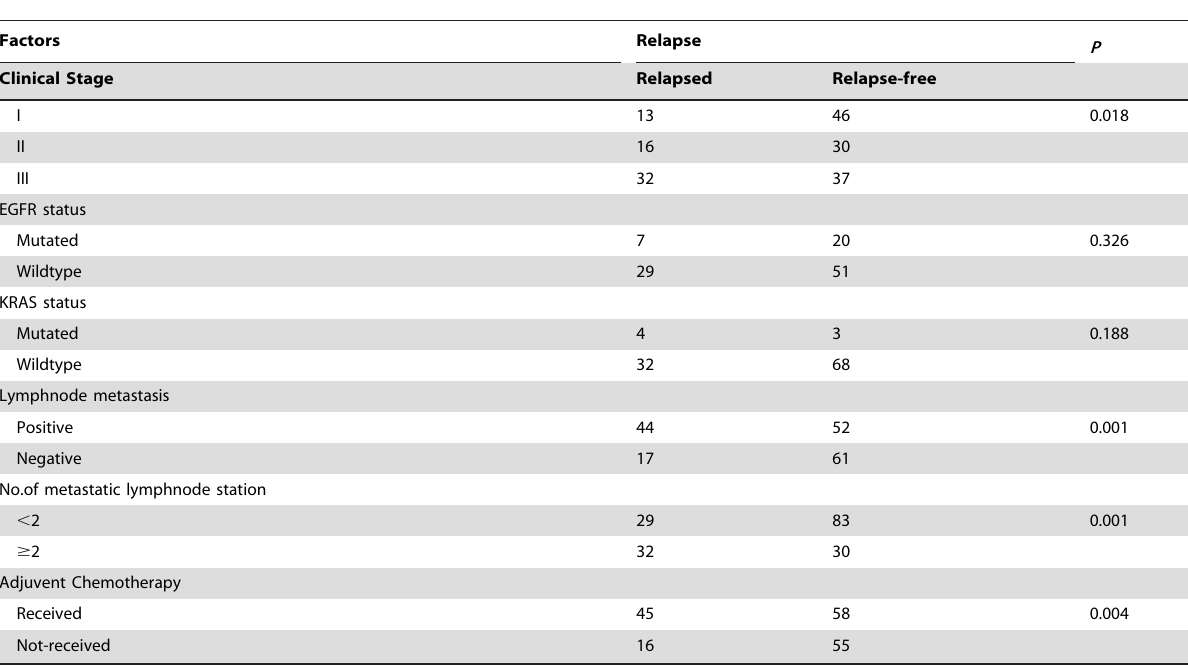
Table 2. Association between clinical and molecular factors and disease